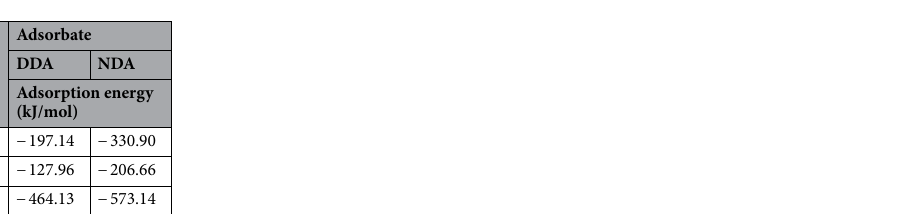
Table 2. Adsorption energy of adsorbate on the surface of magnesite (101), dolomite (101) and quartz